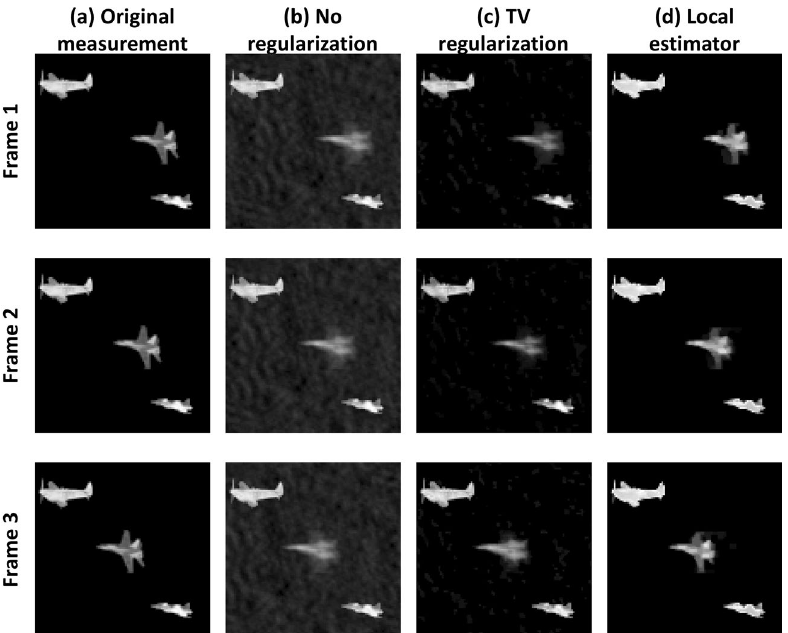
Figure 5. Three frames of a video with local motion. From left to right: the original measurements, reconstruction with matrix inversion Eq. (2), reconstruction with TV regularization Eq. (4), and with our local estimator.